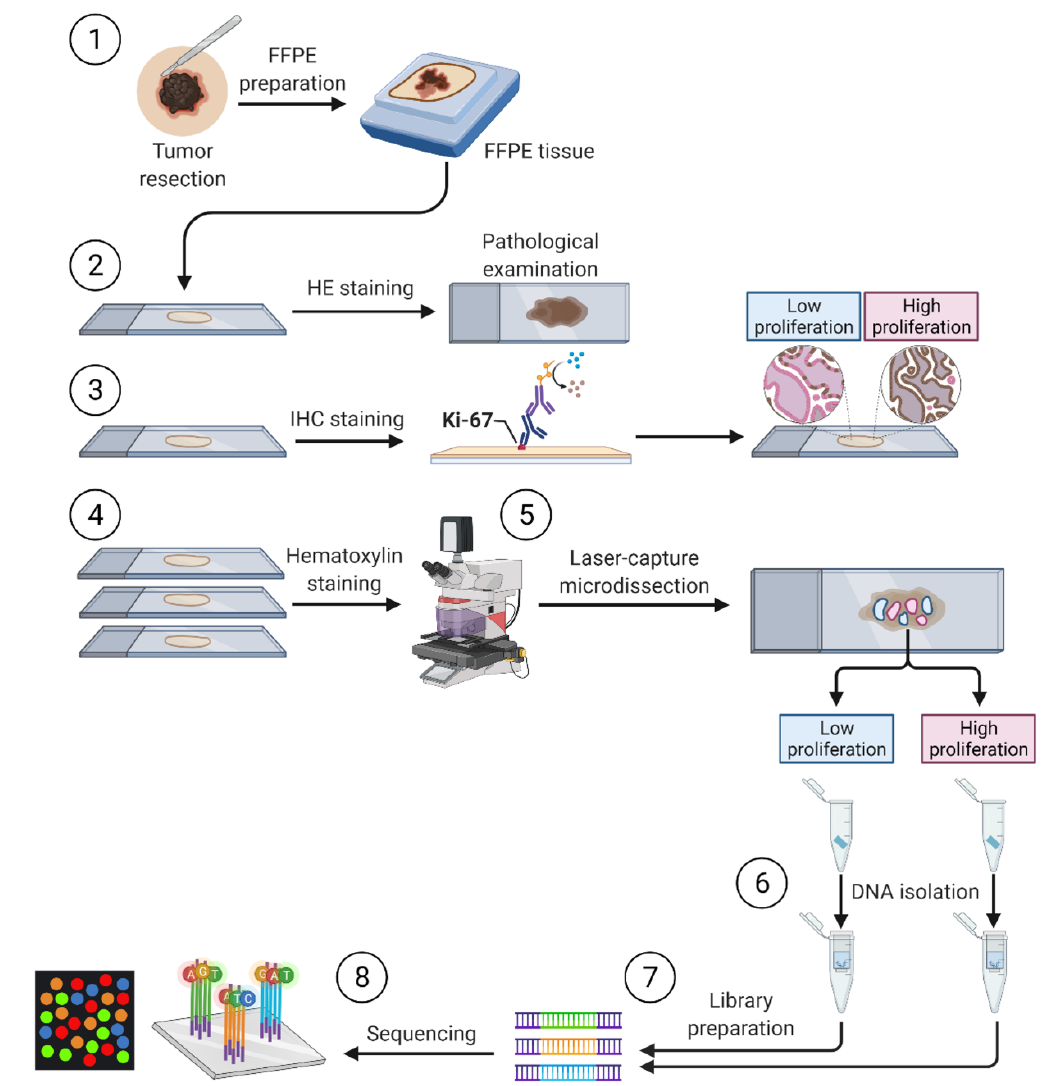
Figure 1. General overview of sample processing. ( 1 ) Preparation of archival formalin-fixed paraffin-embedded (FFPE) originated from primary cutaneous melanoma tumors. ( 2 ) Staining with hematoxylin and eosin (HE) for the pathologist examination. ( 3 ) Immunohistochemistry staining with anti-Ki67 antibodies to determine the compartments of high and low proliferation. ( 4 ) Hematoxylin staining and laser-capture microdissection. ( 5 ) The laser-capture microdissection of compartments of high and low proliferation based on Ki-67 staining. ( 6 ) Digestion with proteinase K and DNA isolation followed by DNA quantity and quality assessment. ( 7 ) Preparation of libraries for amplicon-based next-generation sequencing of a panel of cancer-related genes. ( 8 ) Targeted next-generation sequencing.